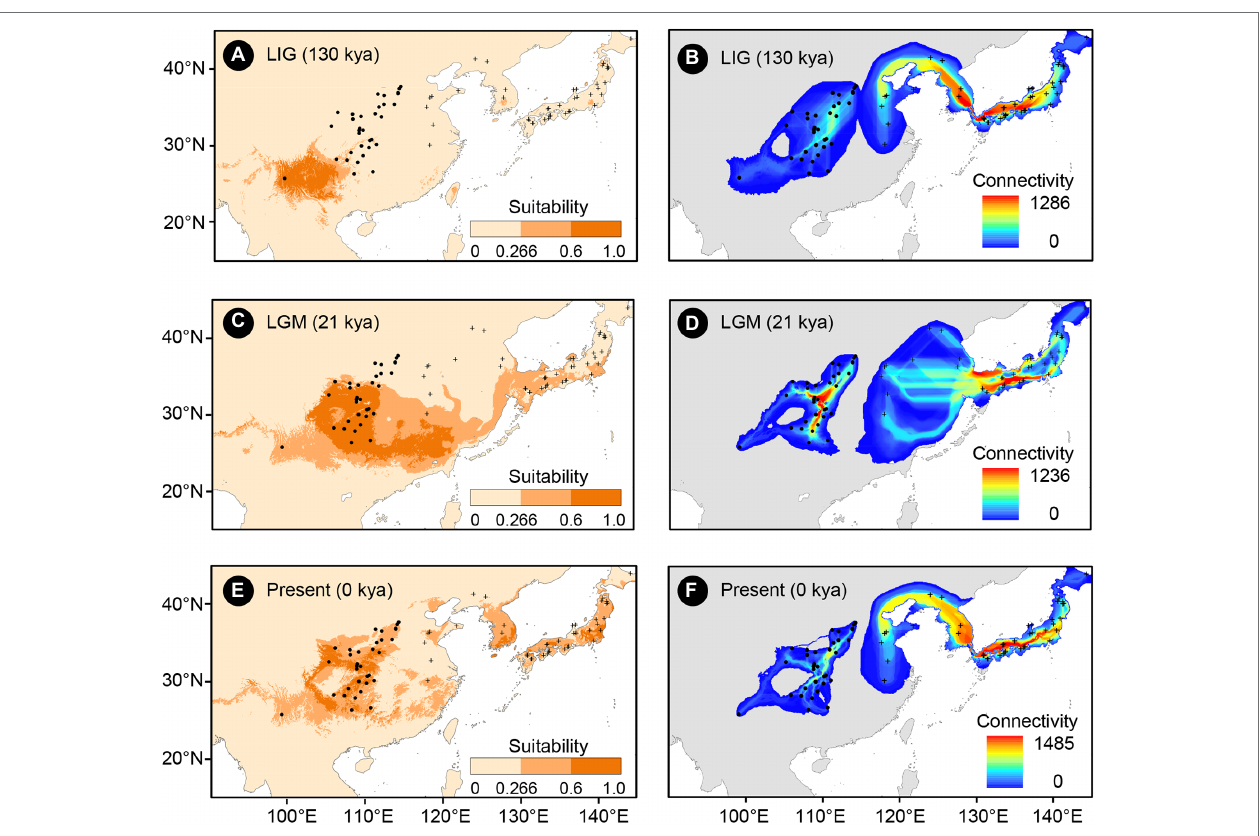
FIGURE 2 | Climatically suitable areas and dispersal corridors of Toxicodendron vernicifluum during the Last Interglacial (LIG; A,B ), Last Glacial Maximum (LGM; C,D ), and the present ( E,F ) based on the outputs of ecological niche modeling (ENM) using Maxent 3.4.1 (Phillips et al., 2018). Black dots and plus signs represent the sampling sites of the western and eastern groups,